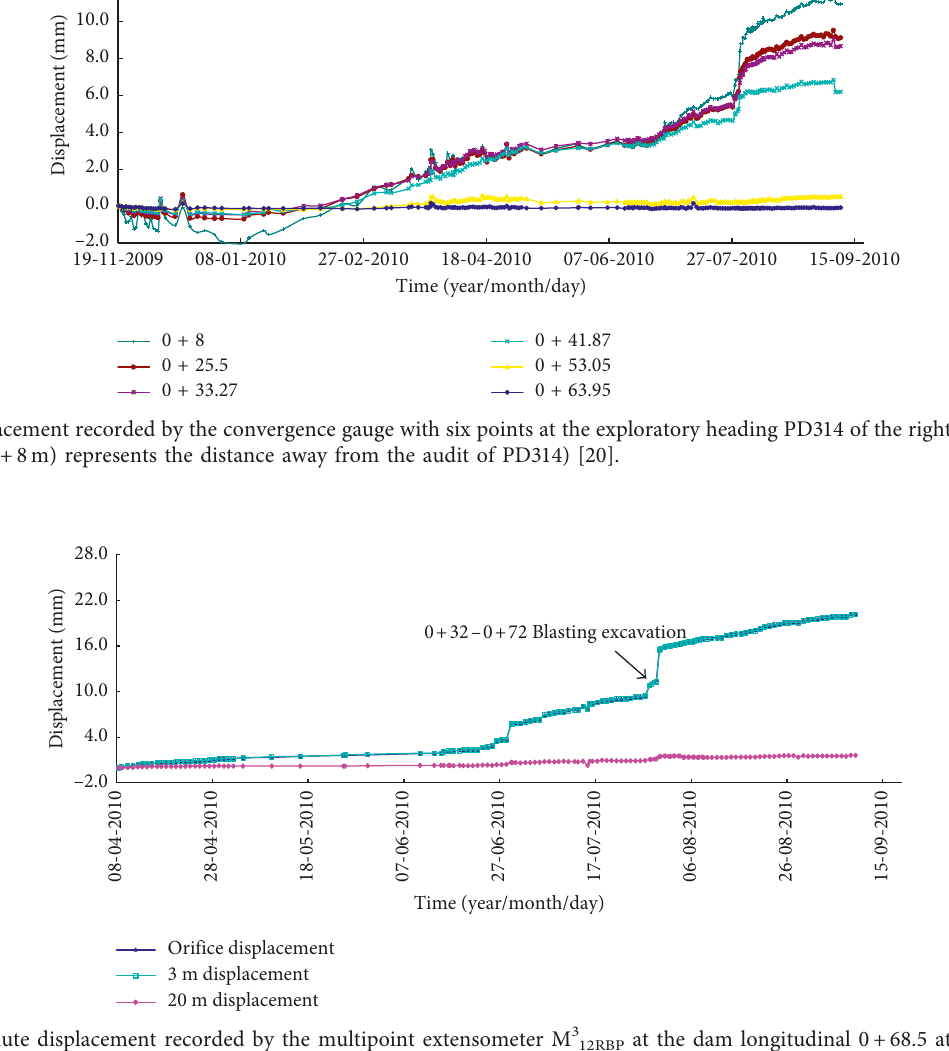
12RBP at the dam longitudinal 0+68.5 at an elevation of